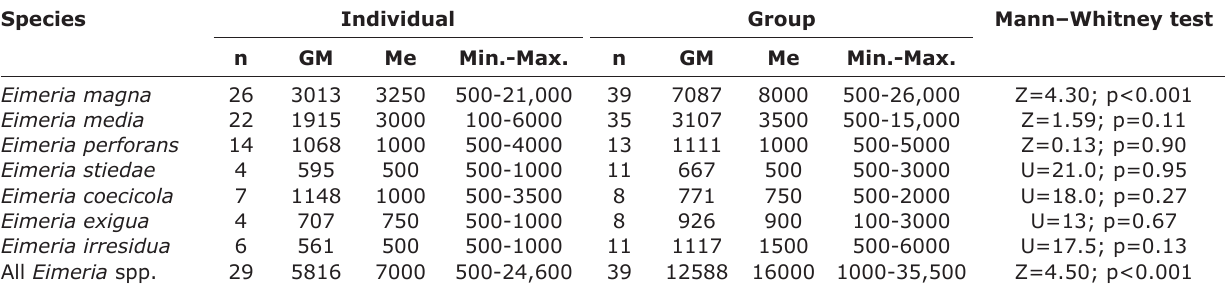
Table-5: Infection intensity (OPG) of rabbits with Eimeria spp. according to the system of animal management. Species